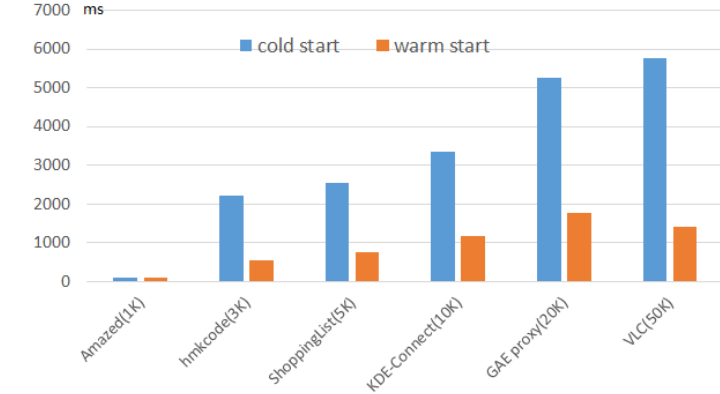
Figure 4. Execution time of PerHelper. The vertical axis denotes the time in milliseconds used to generate permission sets and detect unprotected API methods. The horizontal axis denotes the app name and lines of